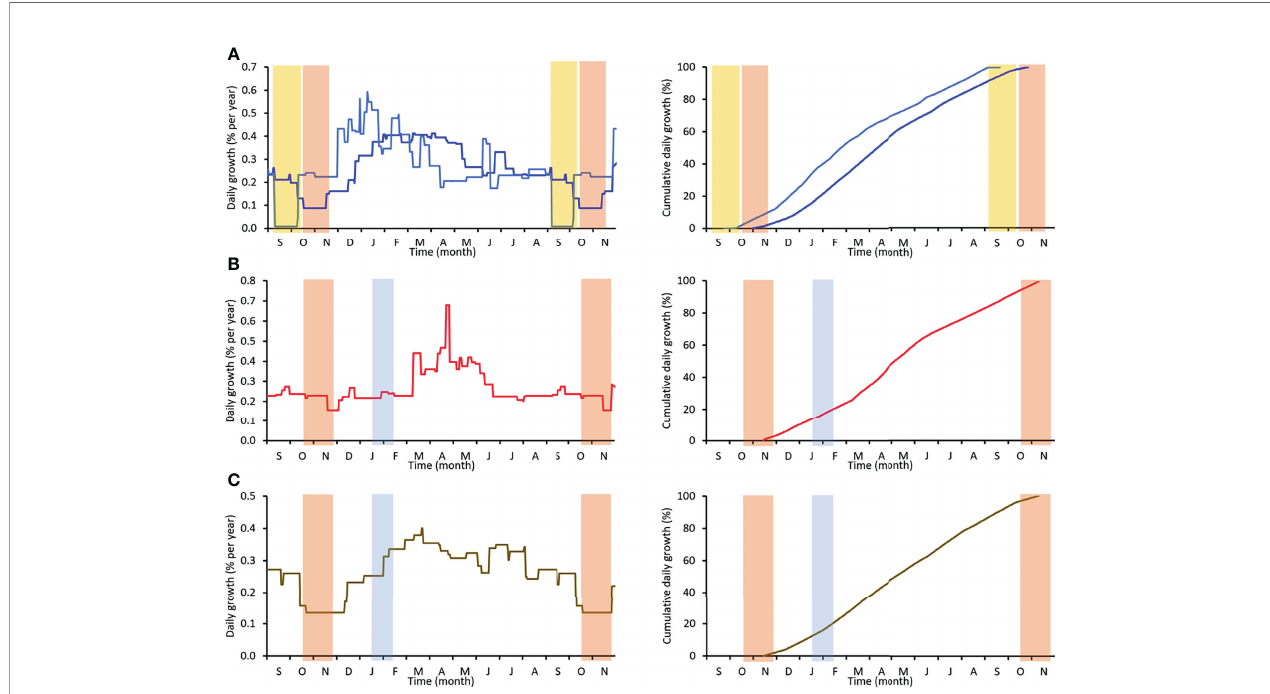
FIGURE 4 | Seasonal growth models of the three studied species based on the oxygen isotope alignment technique. Left panel: daily growth rates, right panel: cumulative growth curves. (A) A. islandica , station FBR36 (Fehmarn Belt) is brilliant blue, St12 (Mecklenburg Bight) in pale blue; (B) A. elliptica , FBR36; (C) A. borealis , FBR06 (Fehmarn Belt). Vertical bars represent annual growth lines. Red, yellow = Mg-rich line at Fehmarn Belt and Mecklenburg Bight, respectively; blue = Mg-depleted growth line. In Astarte spp., the red and blue lines delimit a grey (or Mutvei blue-stained) growth band. Data from Mecklenburg Bight taken from Schöne et al.